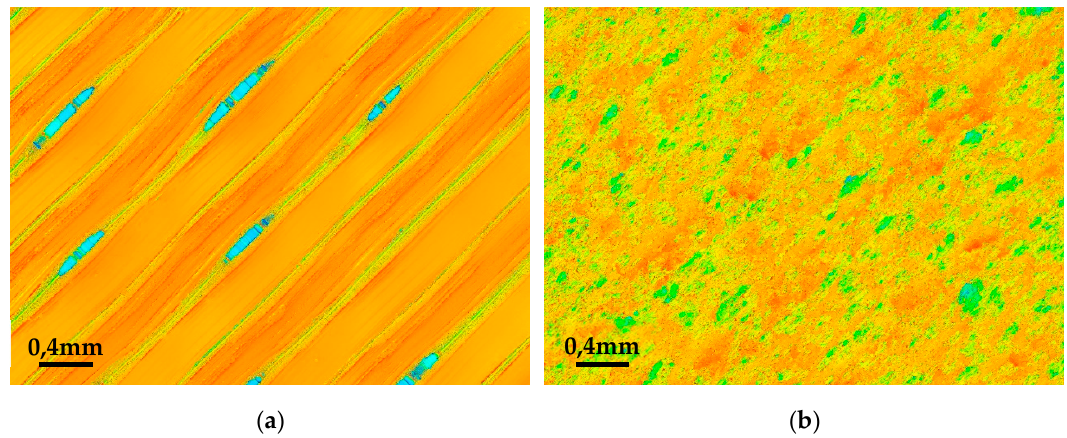
Figure 12. Height images of regular XT specimens ( a ) and XT specimens with embedded carbon fiber ( b ).